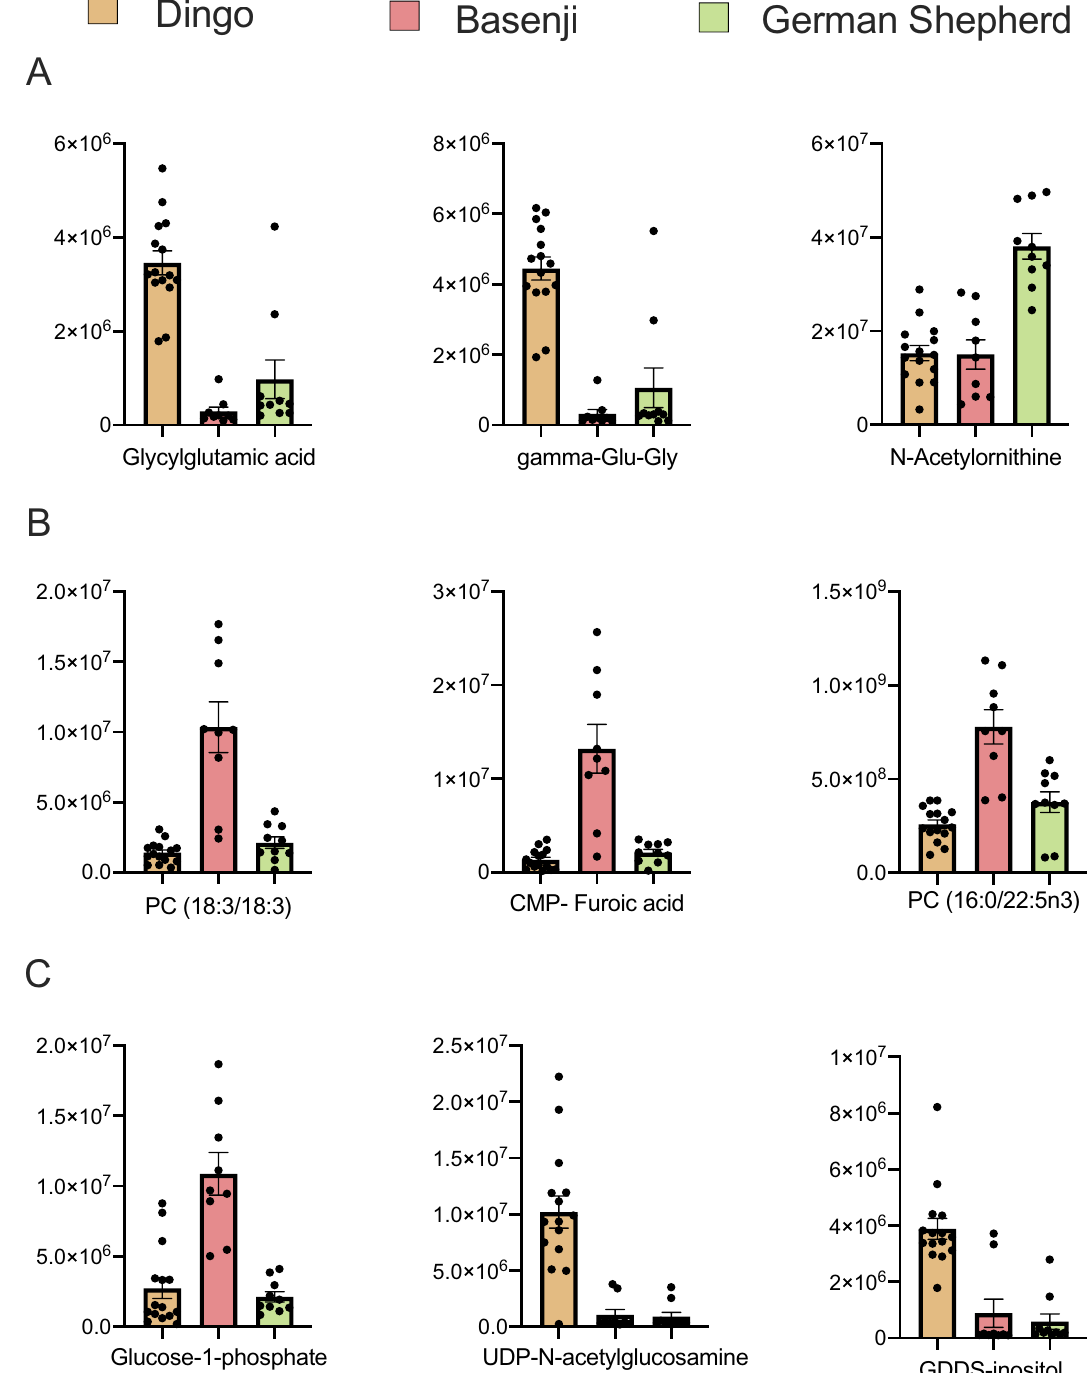
Figure 2. Top three metabolite differences between the dingo, Basenji and German Shepherd Dog based on the lowest P- values: ( A ) Top three protein metabolite differences between the three groups, ( B ) Top three lipid metabolite differences, ( C ) Top three carbohydrate metabolite differences. CMP- Furoic acid: 2-(2-Carboxyethyl)-4-methyl-5-pentyl-3-furoic acid, GDDS-inositol: 1D-1-guanidino-1-deoxy-3-dehydro- scyllo-inositol. Y axis represents normalised area for the metabolite. Plot show mean with